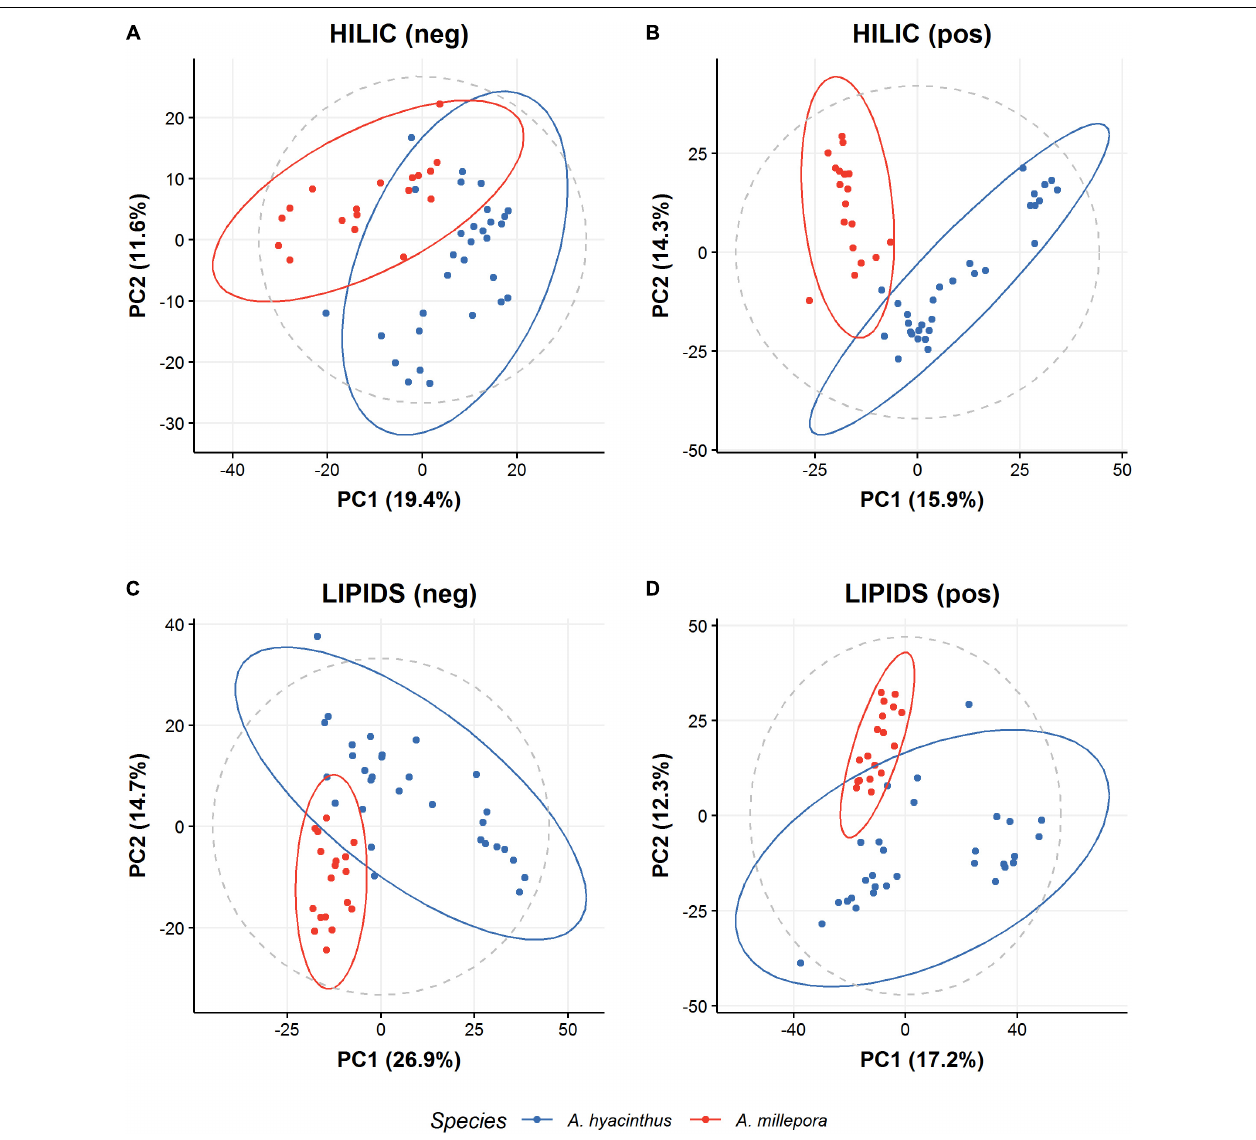
FIGURE 2 | PCA scores representation of metabolomic profiles of A. hyacinthus (blue dots) and A. millepora (red dots) under control “natural” conditions. Results from polar HILIC coral extracts in (A) negative mode and (B) positive mode LC-MS, and of non-polar LIPID coral extracts in (C) negative mode and (D) positive mode